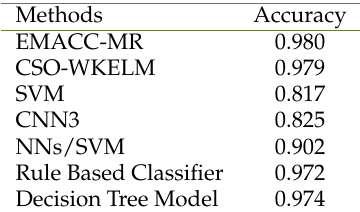
Table 6. Comparative analysis of the Proposed EMACC-MR Method on the Activity Recognition